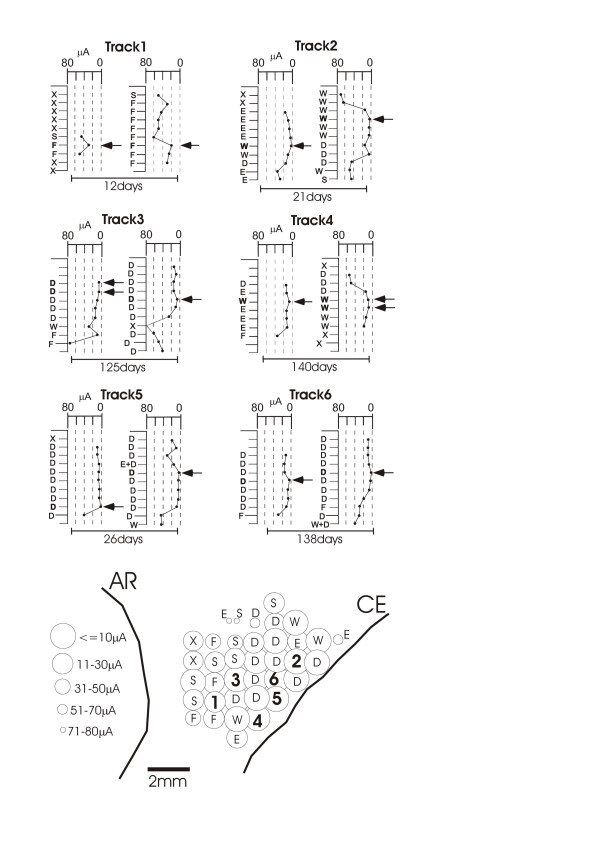
Reproducibility of the intracortical microstimulation method. To investigate the variability of the method, six ICMS electrode tracks (1 to 6) were each performed at two time points, separated by a time interval indicated in days (12, 21, 125, 140, 26, 138) below the horizontal bar. For each track, the penetration drawn on the left is the first one whereas the second, performed at the same location, is displayed on the right. For each penetration, the tics along the vertical line represent the sites of stimulation, at a distance of 1 mm. Usually, the first stimulation site is located 2 mm below the surface of the dura. The horizontal scale (in μAmps) indicates for each stimulation site the lowest current at which the effect was observed. The body territory activated by the ICMS is indicated as follows: "D" = digit; "E" = elbow; "F" = face; "S" = shoulder; "W" = wrist; "X" = non-microexcitable site. Along each penetration, the arrows (and bold letters) indicate the ICMS threshold for the entire penetration (criterion taken to define the body territory for the corresponding location on the surface map). The bottom panel is a surface representation of the left hemisphere of the intact Mk4, in which the six electrode penetrations represented above were performed twice (indicated by the numbers 1–6). The other circles with the same letter code as above represent the other electrode penetrations performed in the left hemisphere of Mk4. The size of the circles represents the ICMS threshold obtained for the corresponding electrode penetration. CE = central sulcus; AR = arcuate sulcus; rostral is to the left and medial towards top.